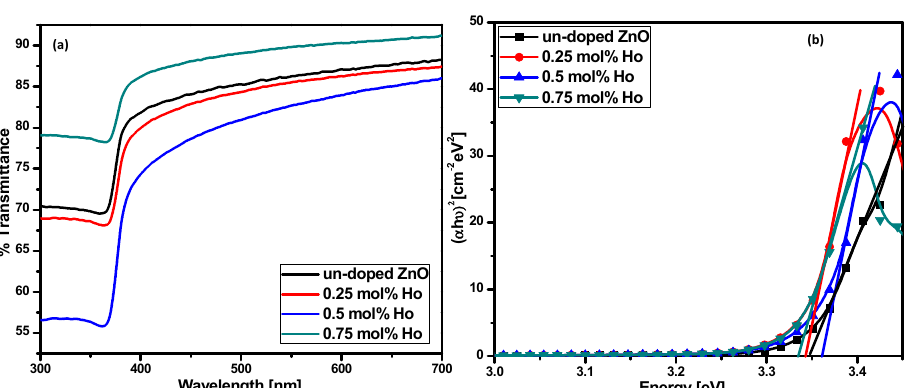
Figure 4. ( a ) UV–VIS transmission spectra for un-doped and Ho 3+ –doped ZnO nanostructures ( b ) optical band–gap extrapolation from Tauc plot.